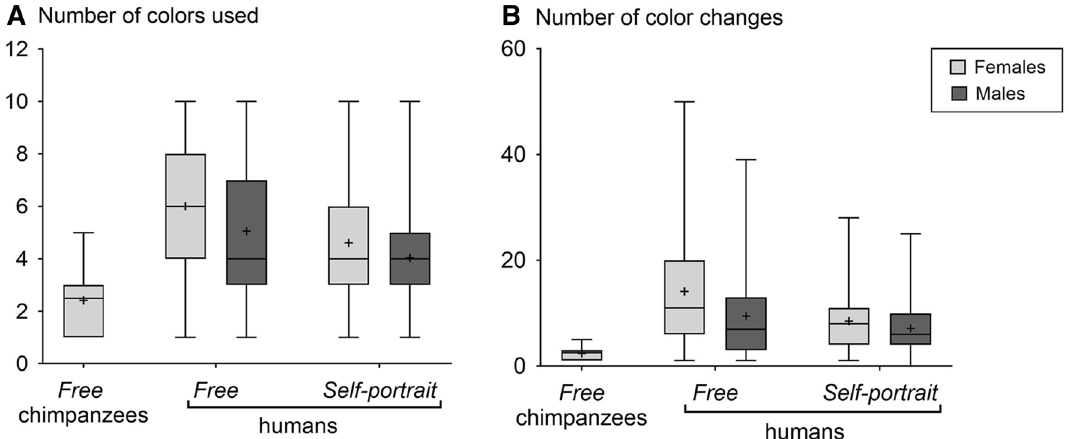
Figure 3. ( A ) Boxplots of the number of colors used by chimpanzees and humans for each condition and for each sex. ( B ) Boxplots of the number of color changes by chimpanzees and humans for each condition and sex. Boxplots depict the median (bold bar), 25–75% quartiles (box), mean (cross) and outliers (points).